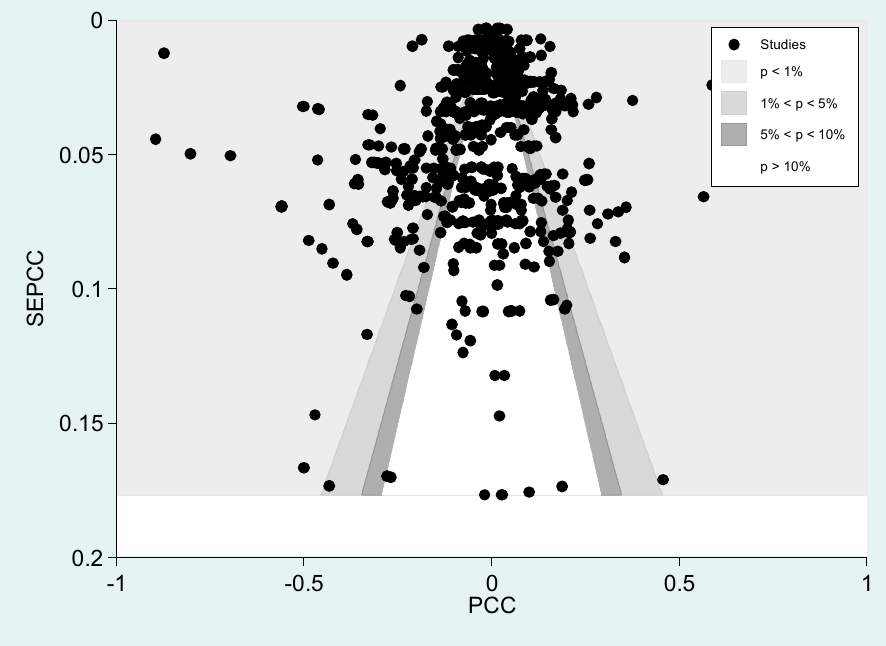
Figure 3. Contour-enhanced funnel plot of standardized effects of capital on risk (PCC).